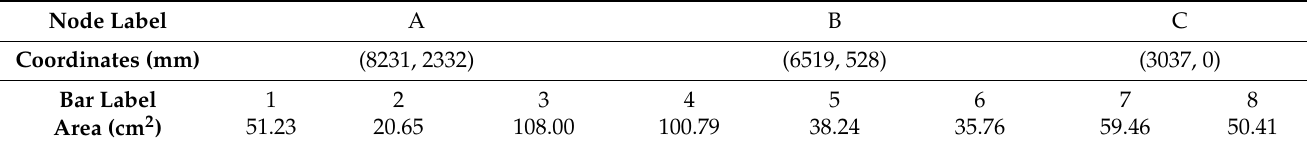
Figure 7. Optimal truss layout generated in experiment 1. Table 3. Detailed data of the generated truss in experiment 1.